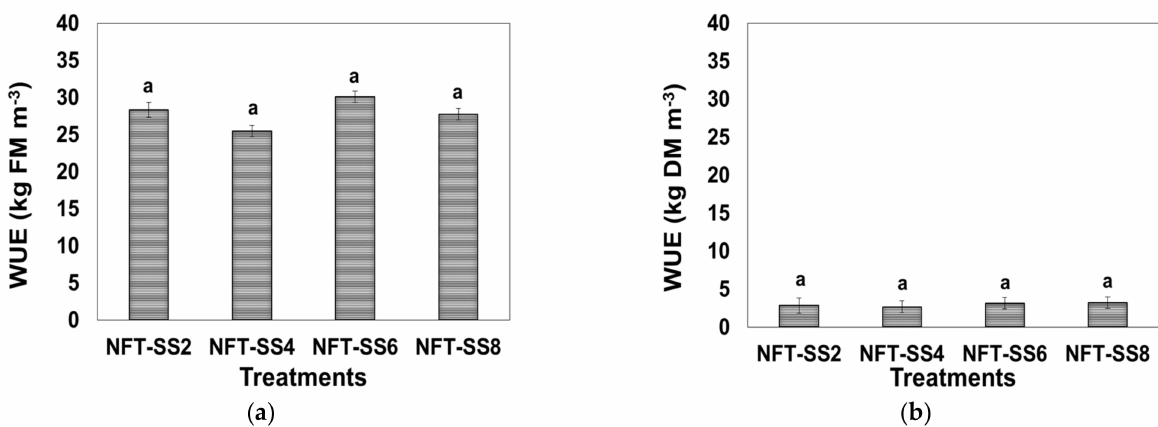
Figure 7. Water use efficiency (WUE, kg m − 3 ) based on the ( a ) fresh matter (FM) and ( b ) dry matter (DM) of basil crops during the second experimental period. Means followed by different lowercase letters (a, b) differ significantly according to the Tukey–Kramer HSD test at p < 0.05 across the fertigation